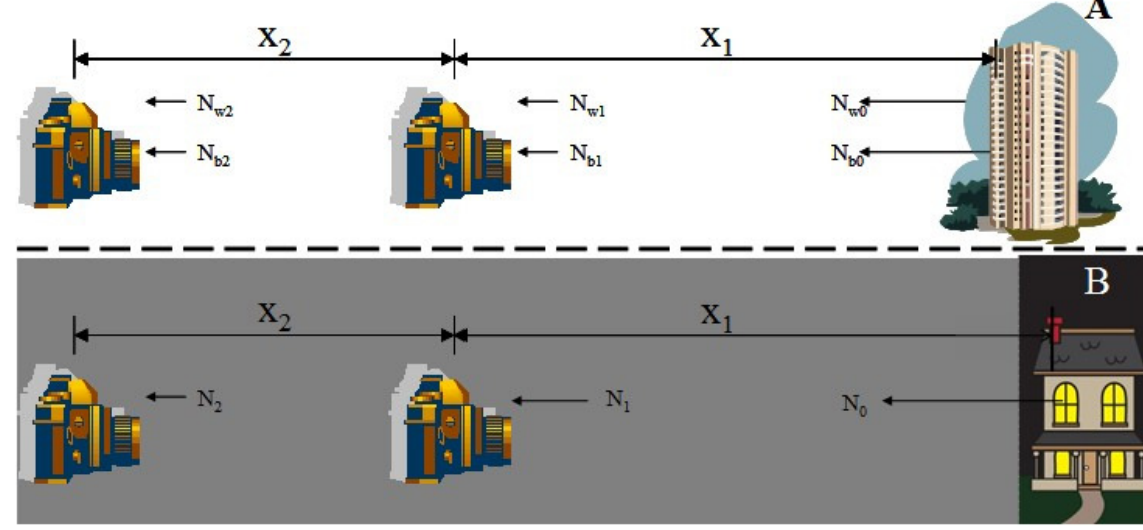
Fig. 1. Schematic describing how DOM-Vis takes pictures of a target at distances of X 1 and X 2 during daytime (A) and nighttime (B) .